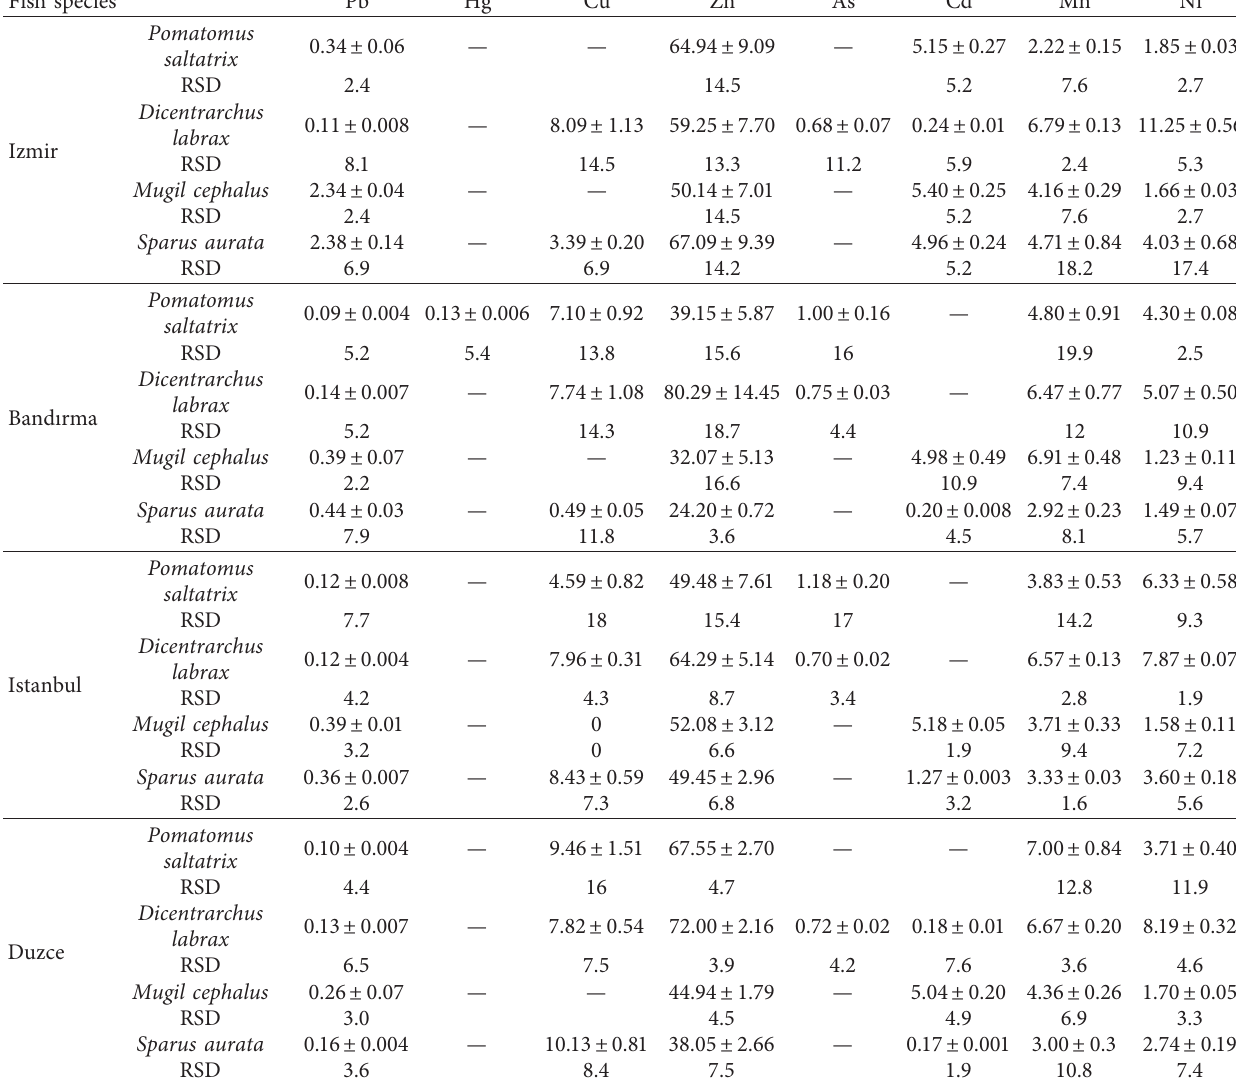
Table 2: Concentration of Pb, Hg, Cu, Zn, As, Cd, Mn, and Ni residues ( μ g/g) in muscle tissues of fish samples. Fish